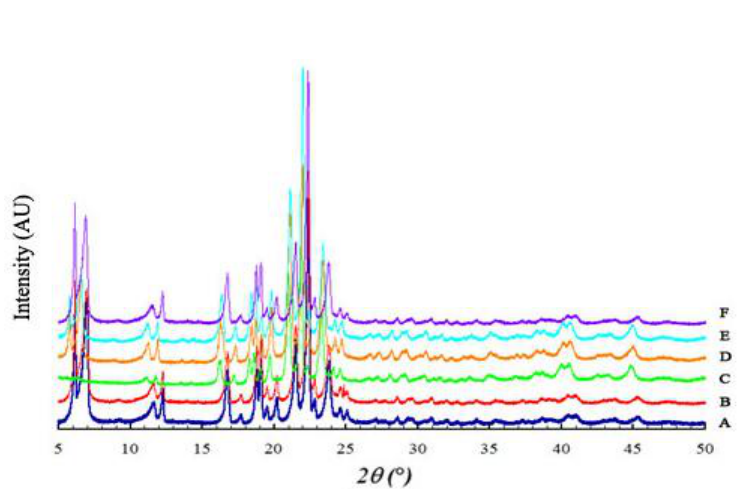
Figure 4. X-ray diffractograms of 4:6 weight ratio ibuprofen-stearic acid binary mixture under compression force of A. 4.9kN, B. 9.9kN, C. 14.9kN, D. 19.9kN, E. 24.9kN, and F. 29.9kN.